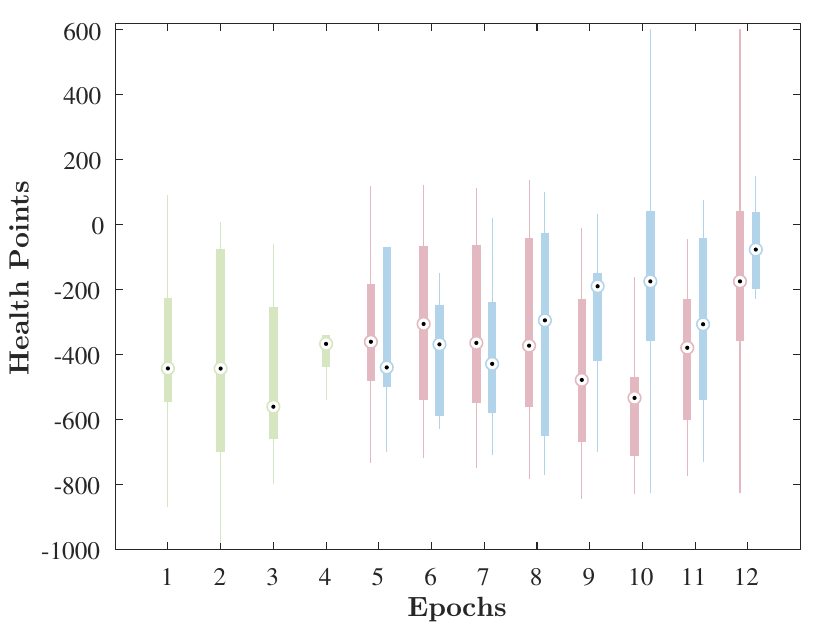
Figure 5. Box plots of the learning rates of three different